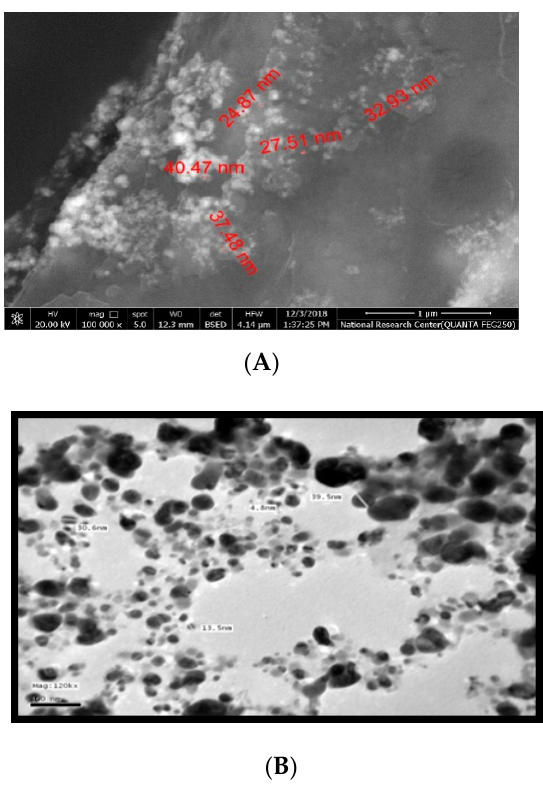
Figure 2. SEM ( A ) and TEM ( B ) micrographs of round state of Ag-nanoparticles of mustard with a size range from 4.8 to 39.5 nm.